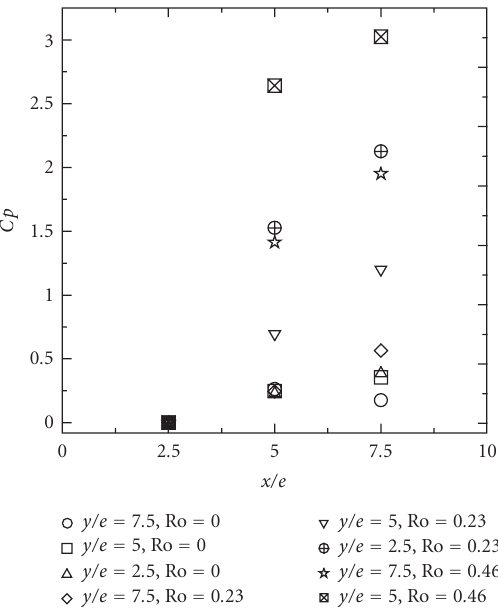
Figure 13: E ff ect of rotation number for 90 ◦ orientation at di ff erent “ y/e ” locations for a Reynolds number of